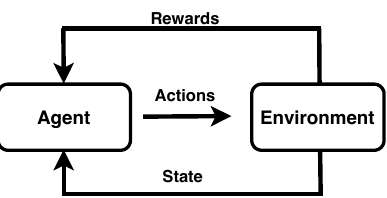
Figure 10. Reinforcement Learning: a software agent takes actions in the environment in order to maximize the